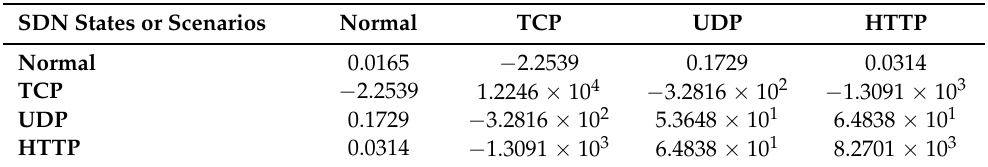
Table 7. Covariance matrix for R t when the SDN is operating normally and subjected to popular variants of DDoS flooding